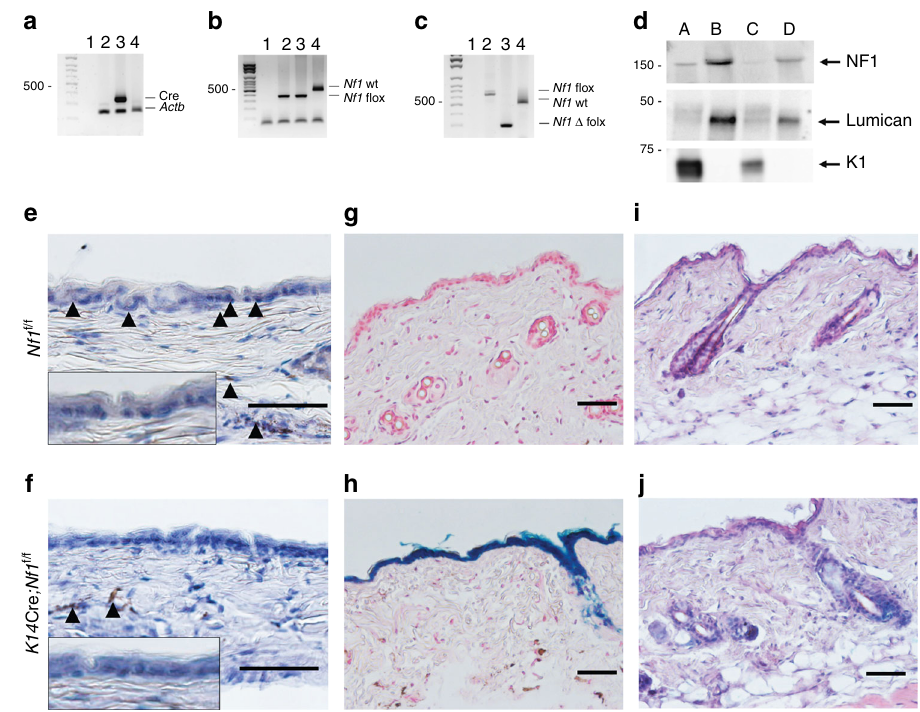
Fig. 2 Loss of Nf1 in keratinocytes does not trigger obvious skin phenotype. Mice genotyping with speci fi c PCR primers for a Cre recombinase, b Nf1 fl ox allele and c Nf1 deleted. Lane 1 = no template control, lane 2 = DNA from Nf1 f/f mice ’ s skin tail, lane 3 = DNA from K14 Cre; Nf1 f/f mice ’ s skin tail, lane 4 = DNA from wild-type mice ’ s skin tail. d Western blot of skin protein extract quanti fi ed using anti-NF1, anti-LUMICAN (dermal marker), and anti-K1 (epidermal marker). Lane A = epidermis from Nf1 f/f mice; Lane B = dermis from Nf1 f/f mice; Lane C = epidermis from K14 Cre; Nf1 f/f mice; Lane D = dermis from K14 Cre; Nf1 f/f mice. e, f Representative IHC using anti-NF1 antibodies of dissected normal dorsal skin from e Nf1 f/f and f K14 Cre; Nf1 f/f (arrow